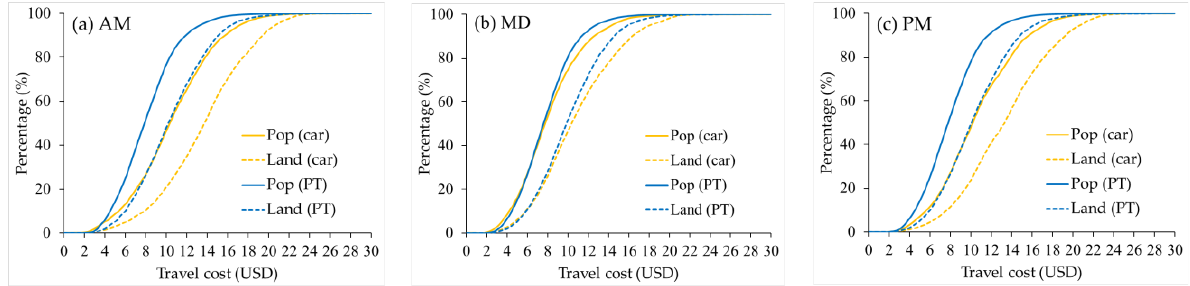
Figure 7. Growth curves of cumulative land and population percentages as travel cost increases: ( a ) during AM; ( b ) during MD; ( c ) during PM.